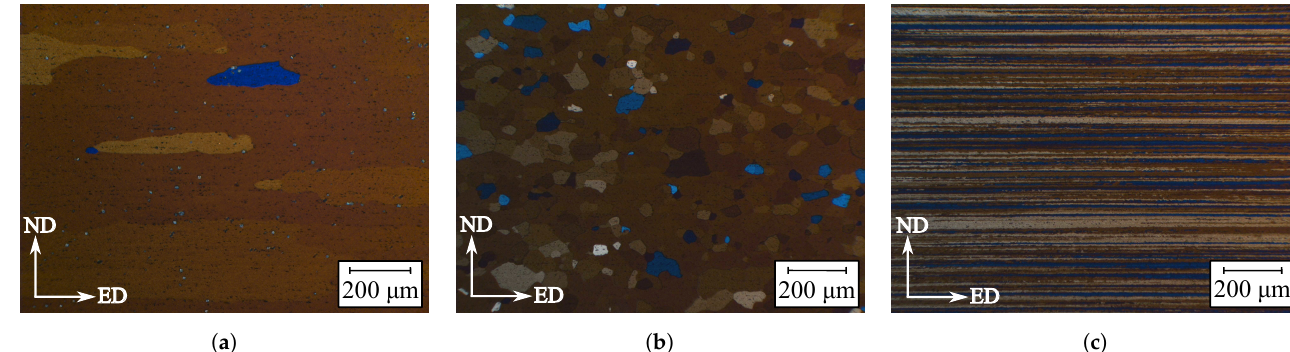
Figure 3. Optical micrographs of the grain structure after extrusion of the alloys ( a ) AA6061, ( b ) AA6063 and ( c ) AA6110, showing recrystallized (AA6061 and AA6063) and non-recrystallized (AA6110) grain structures.